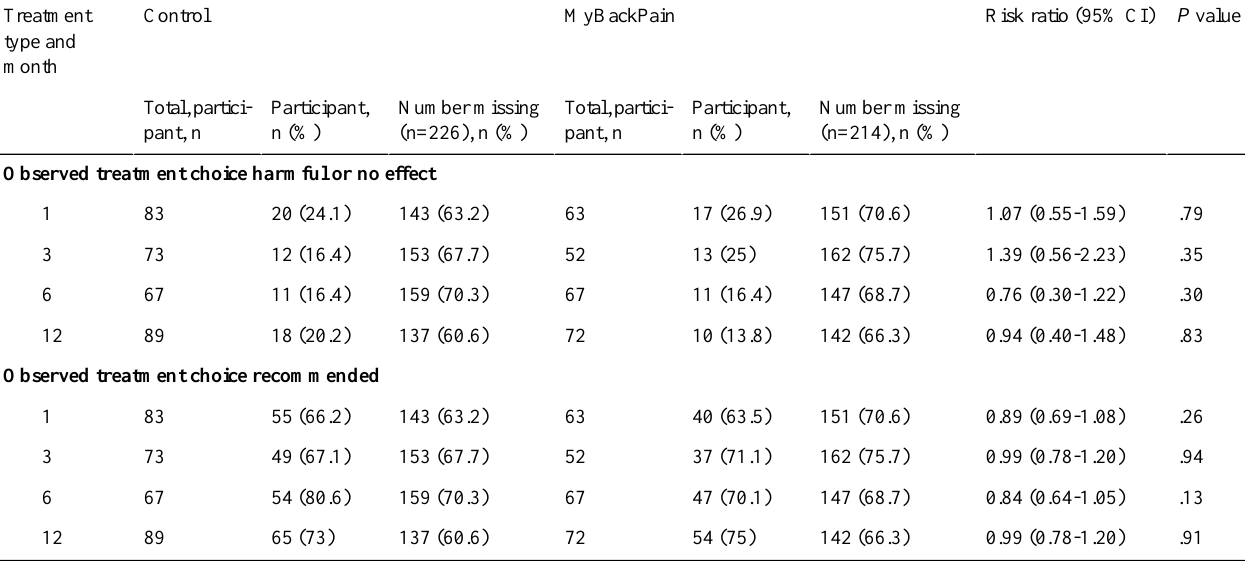
Table 2. Participants choosing treatment types (the binary outcomes) a